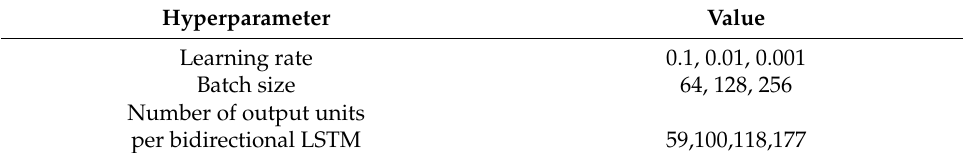
Table 7. Hyperparameters for bidirectional LSTM sequence-to-sequence model grid search.